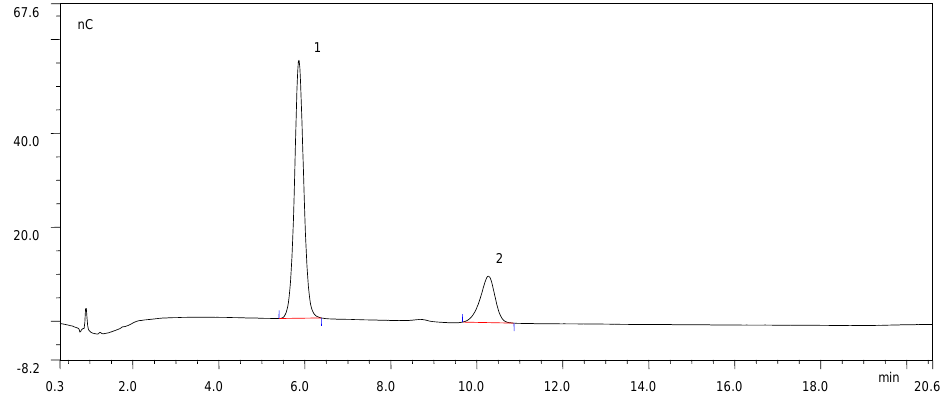
Figure 4. Chromatography profiles of the hydrolysates by TrAbf62A from soluble wheat arabinoxylan. 1, arabinose; 2, xylose.